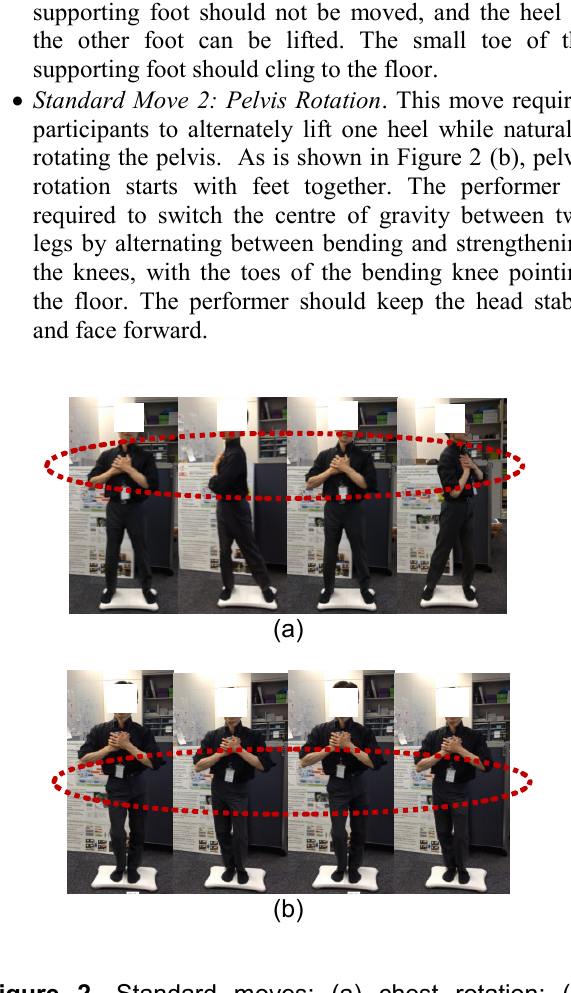
Figure 2. Standard moves: (a) chest rotation; (b) pelvis